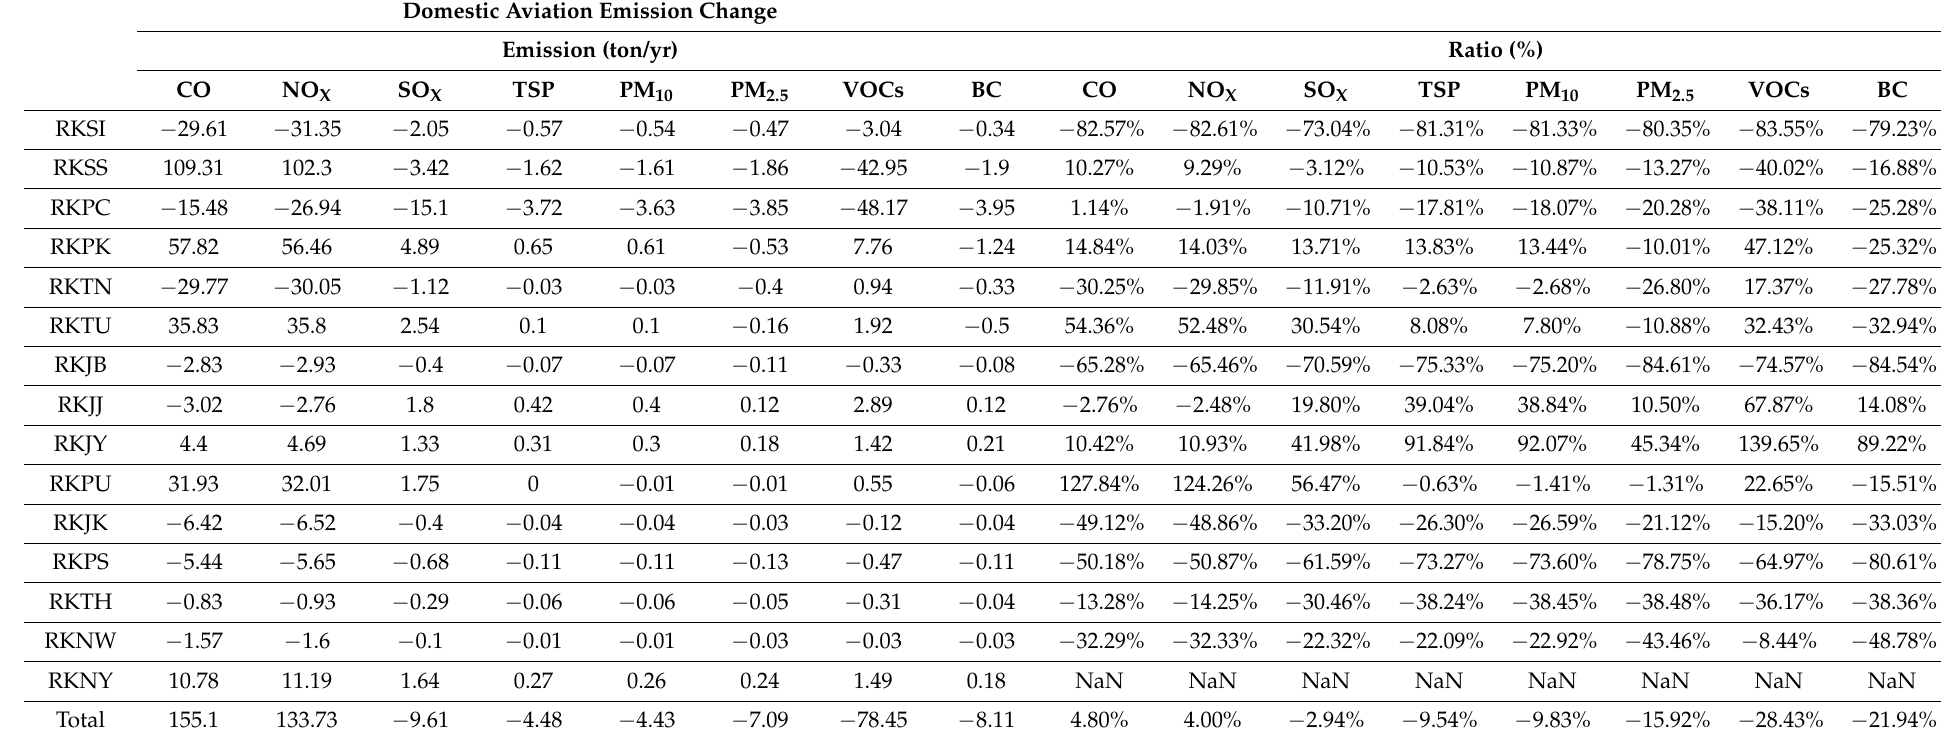
Table 3. Emissions Change due to COVID-19 in Domestic Aviation